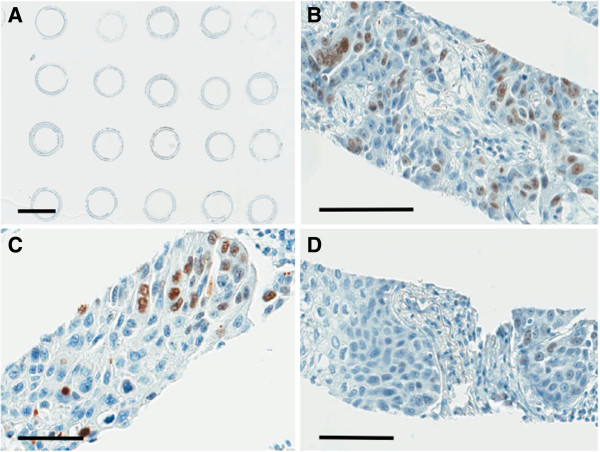
Grading of Ki-67 immunohistochemical staining on Spiral Array. Ki-67 positive ratio of tumor cells in a high power field (×400 magnification). Tumor cells with stained nucleus by the diaminobenzidine tetrahydrochloride, regardless their intensities, are count as positive. A) Scanning view of the Spiral Array slide stained with Ki-67. (bar = 5 mm). B-D) Examples of reels showing Ki-67 staining of Grade 3, > 30% (B); Grade 2, 11-30% (C); Grade 1, 1-10% (D). (bars in B, C, D = 100 μm).